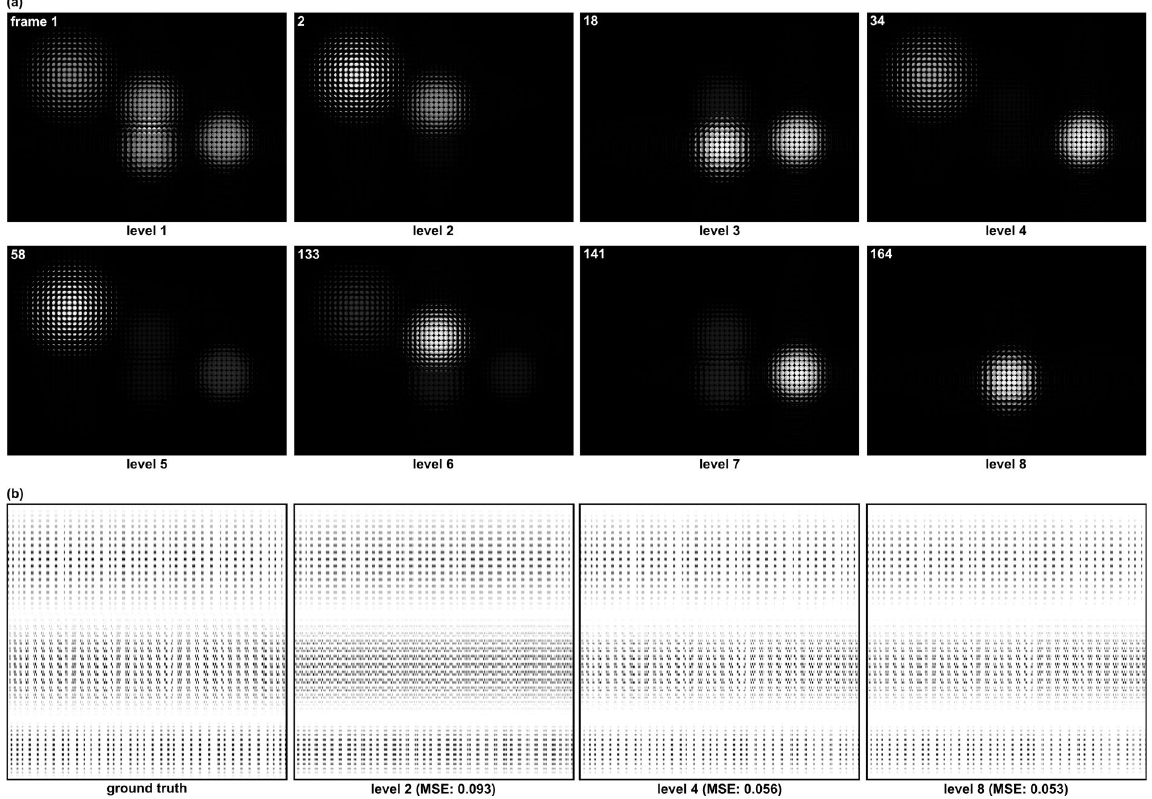
Figure 2. Our algorithm applied to a 4D light-field simulation of four particles. ( a ) Example imaging light-field frames (MLA recordings) for scanning levels 1 to 8. ( b ) The ground truth and updated estimates of the light- transport matrix with corresponding mean squared errors (MSE). Note that unused and empty illumination and imaging rays (i.e., empty columns and rows) are not shown in the matrix. Furthermore, we down-sampled the imaging dimension of the light transport for better visibility (from 2,881,200 to 2352 rows). The light- transport sampling processing for simulated and measured data is also shown in the supplementary